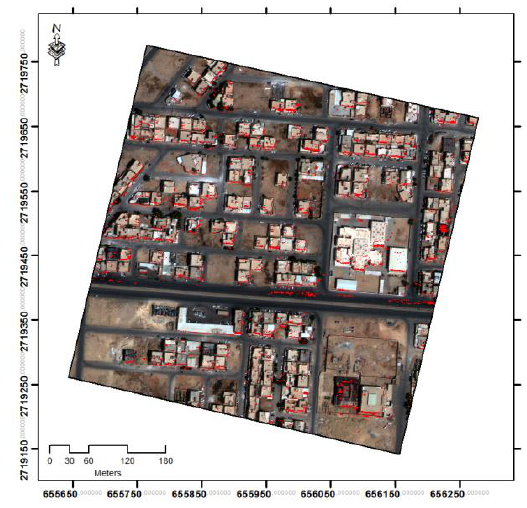
Figure 2. Mismatch mask, superimposed to one GeoEye image As asphalt areas cause problems in the matching stage, the road network mask is a good tool to further reduce errors. The GIS road network superimposed to one of the images is shown in Figure 3.